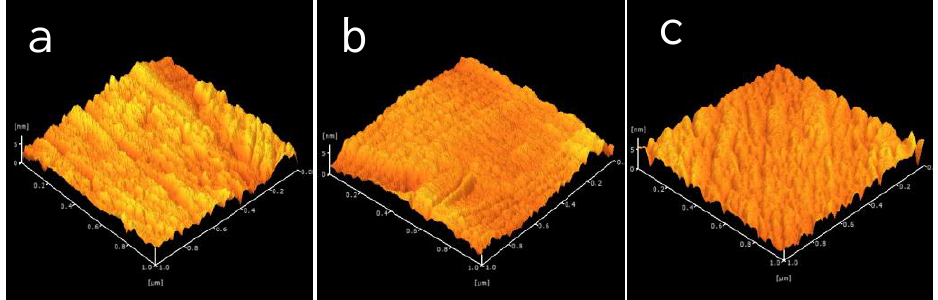
Figure 4. AFM images of HfO 2 thin films with various Tempractures ( a ) 450 °C ( b ) 500 °C ( c ) 550 °C.